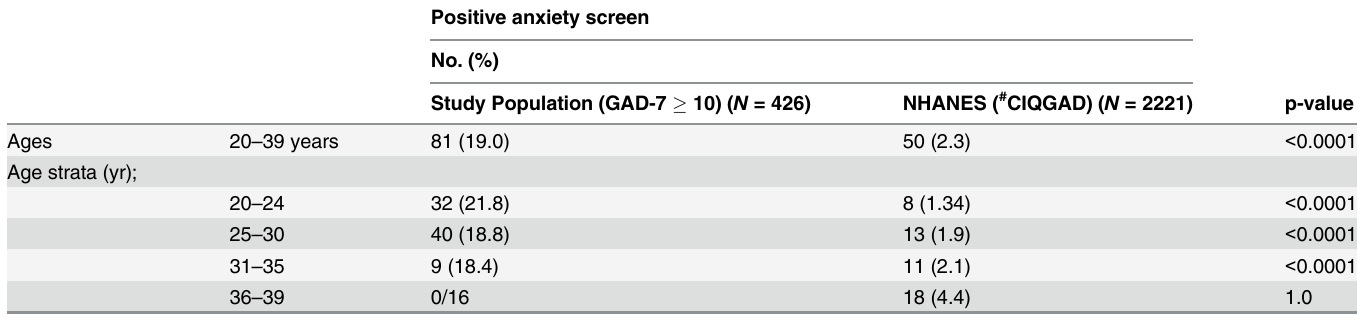
Table 4. Comparison of positive anxiety screens between study population (years 2013 – 2014) and NHANES population (years 1999 –